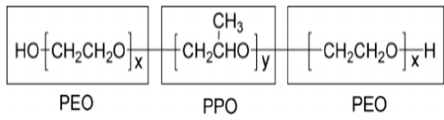
Figure 2. Structure of the self-assembling polymer Pluronic P123.